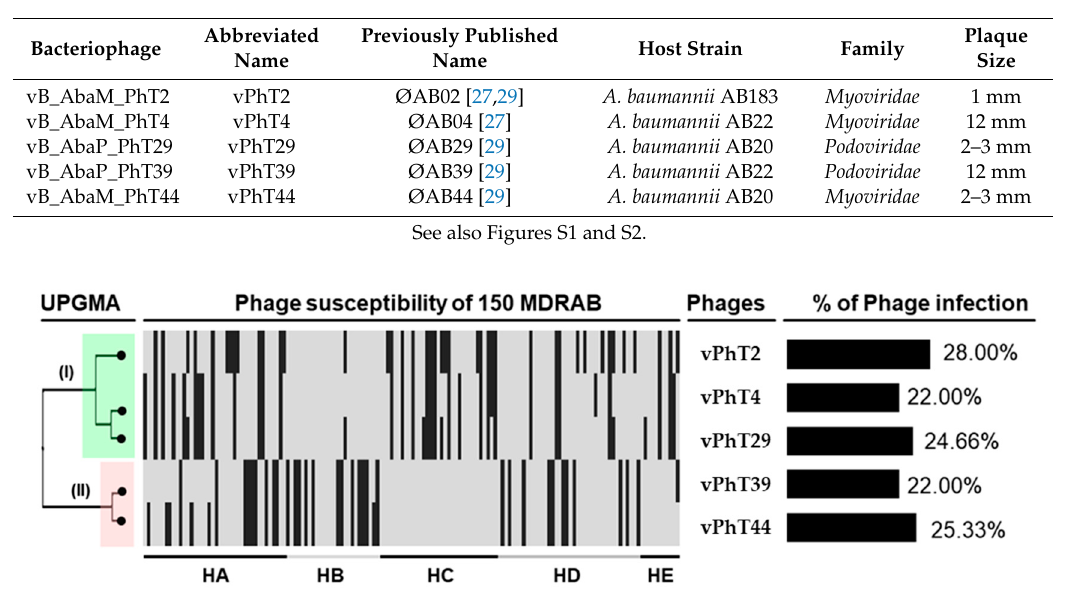
Figure 1. Information on host ranges of Thai bacteriophages against 150 multidrug resistant Acinetobacter baumannii (MDR-AB) strains from five hospitals. From left to right are presented: a UPGMA (Unweighted Pair Group Method with Arithmetic mean) dendrogram, host susceptibility to isolates from di ff erent hospitals (black = A. baumannii isolates susceptible to bacteriophages (clear plaque), grey = A. baumannii isolates resistant to the bacteriophages (no plaque), HA–HE = hospitals A–E) and bacteriophage names and percentage host